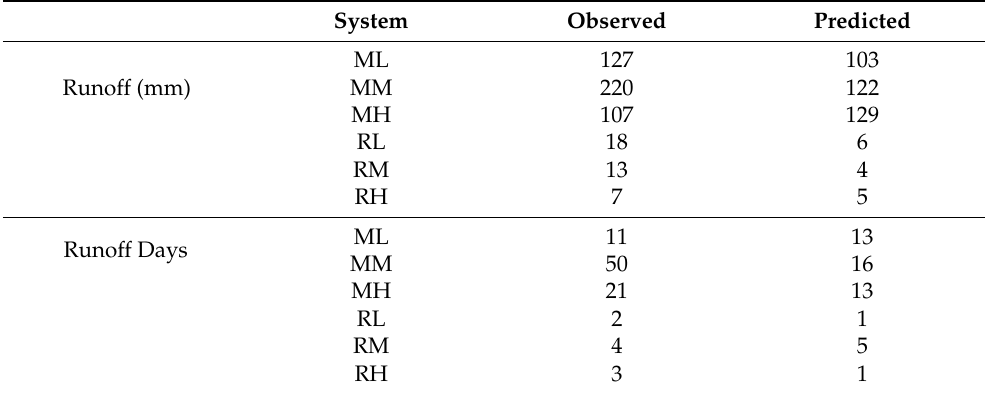
Table 5. Observed and predicted total annual runoff (mm) and number of surface runoff days for the different grazing systems from 1998 to 2001.